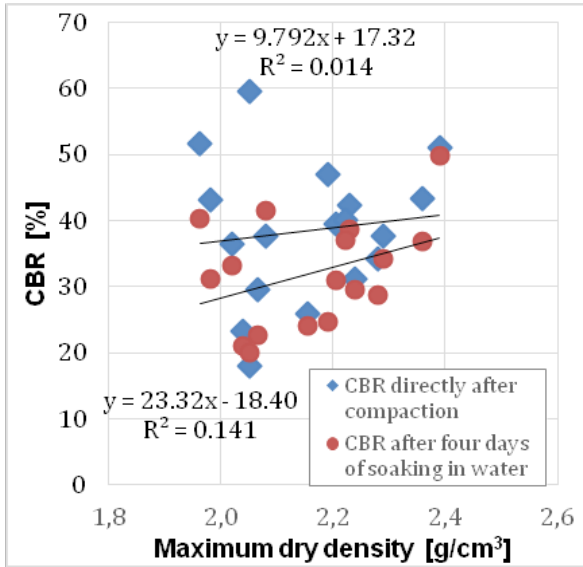
Figure 8: Correlation between CBR value and maximum dry